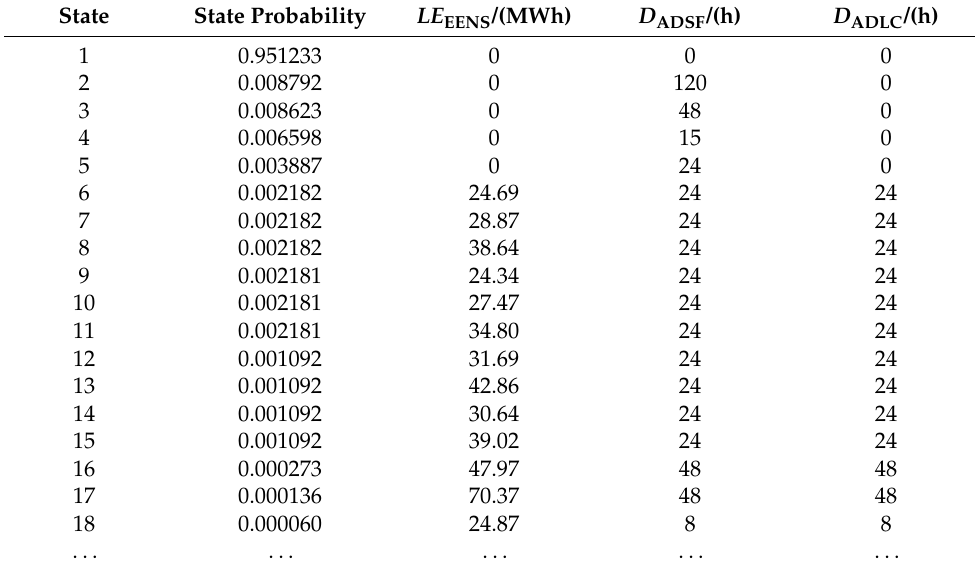
Table 5. Part of the power distribution system outage